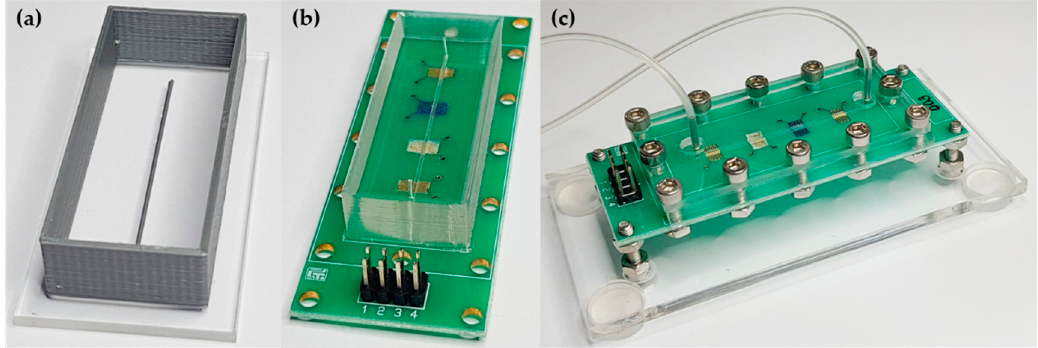
Figure 2. Steps of microchannel fabrication: ( a ) 3D-printed mold for PDMS casting; ( b ) PDMS microchannel aligned on the four collinear sensing units (IDEs covered with LbL films); ( c ) Final device comprised of four sensing units in a single microfluidic channel.